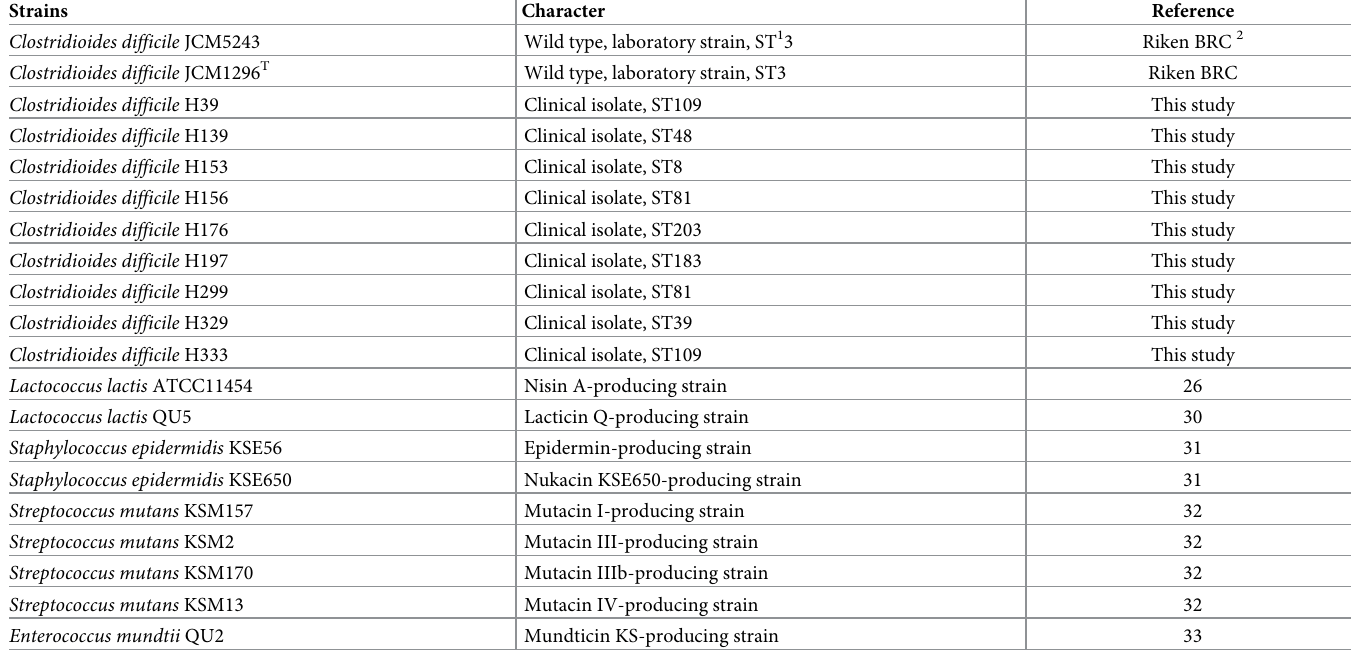
Table 1. Strains used in this study.